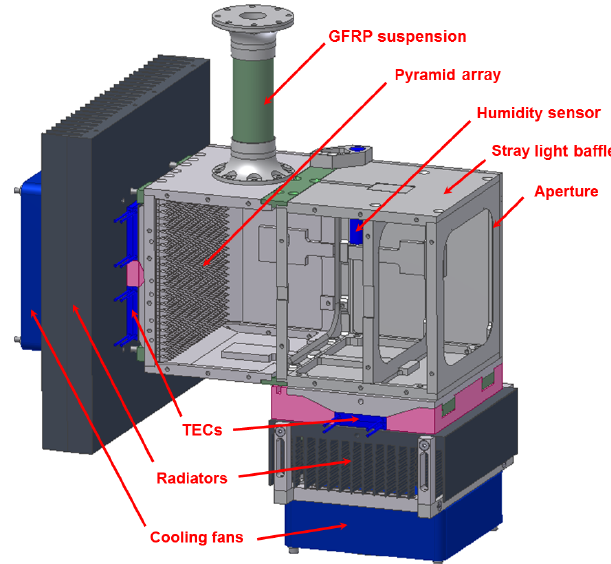
Figure 3. Design of the GLORIA calibration blackbodies (courtesy: Friedhelm Olschewski, BUW,